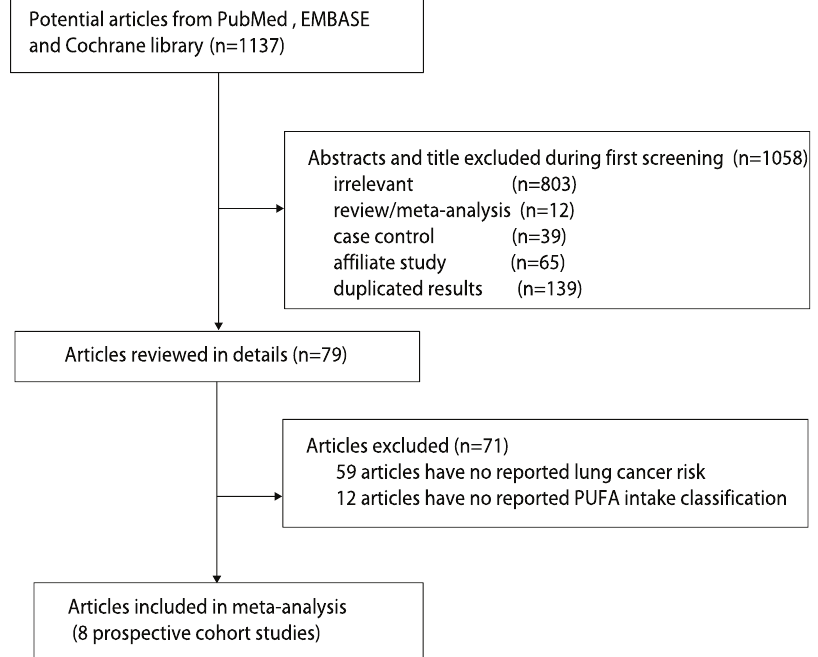
Figure 1. Flow diagram of the literature search and studies selection process.